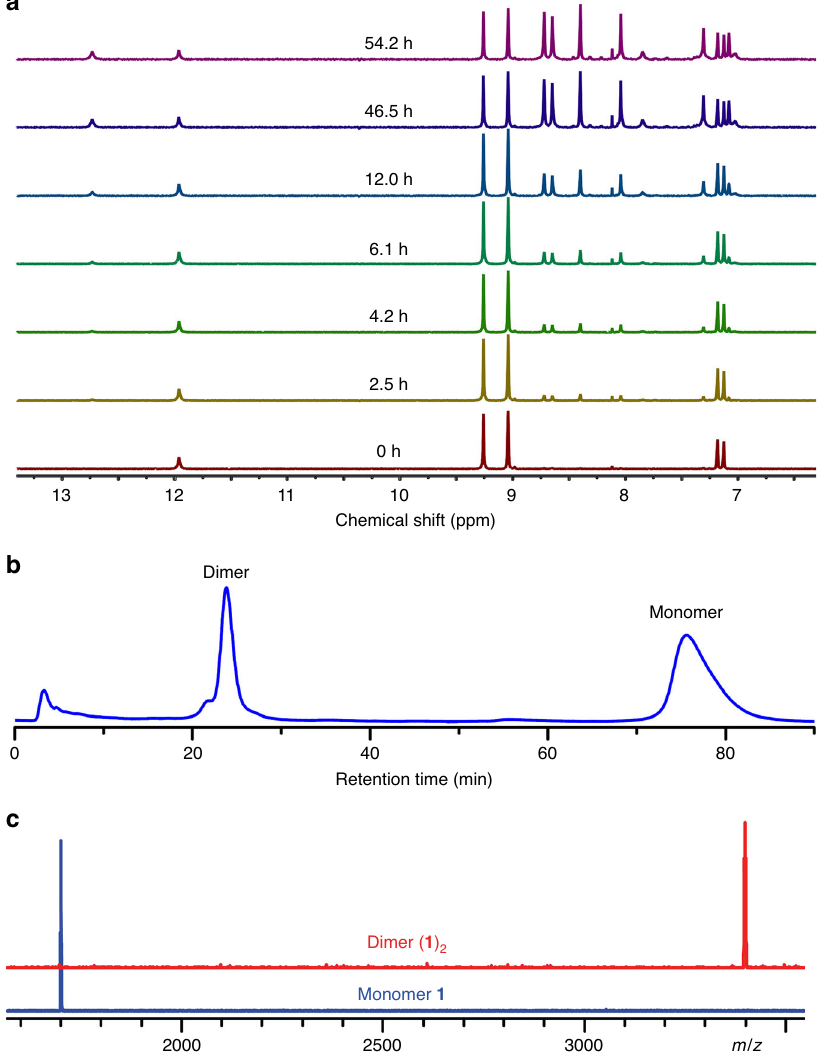
Fig. 4 Dimerization of 1. a Time-dependence of the 1 H-NMR spectra of 1 at 30 °C measured in C 2 Cl 4 D 2 . Chemical equilibrium is attained after 34.4 h. b HPLC chromatogram of the equilibrated sample using a 5PBB HPLC column (I.D. 10 × 250 mm) at a fl ow rate of 4 mL/min with toluene as mobile phase. c The mass spectra of 1 and ( 1 ) 2